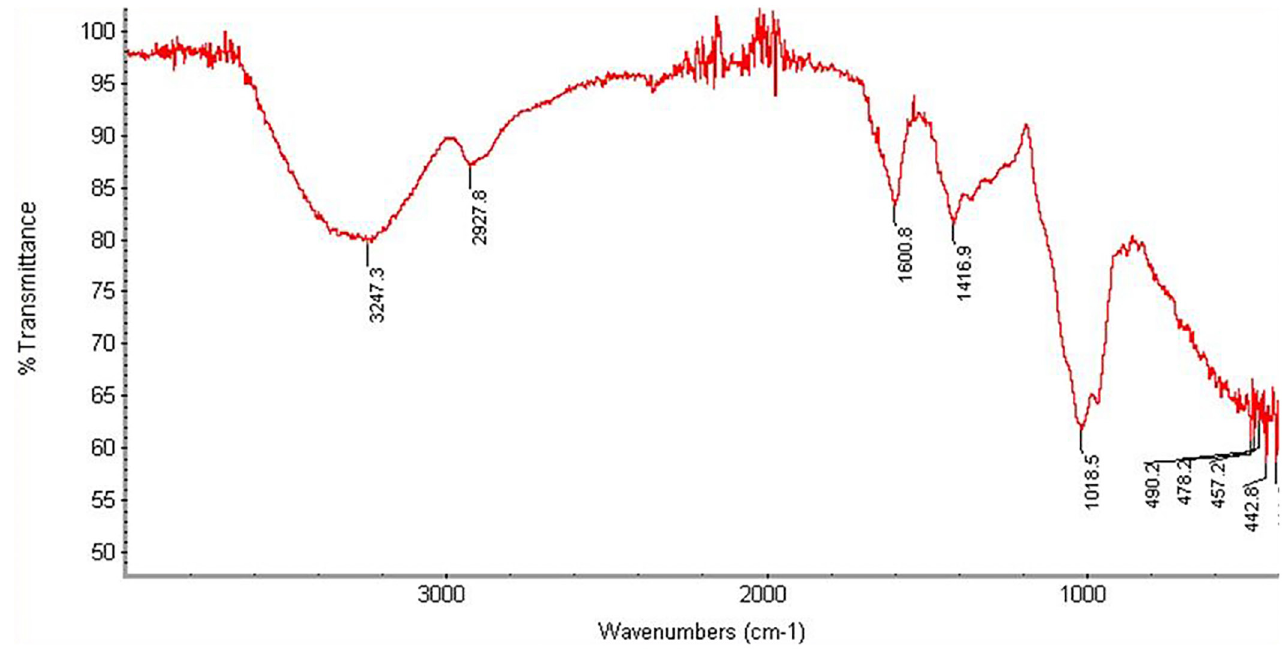
FIGURA 3 - FTIR Spectrum of Mulva neglecta